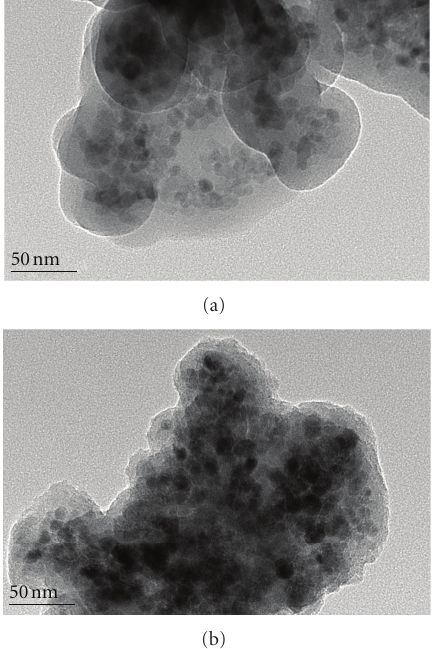
Figure 4: TEM images of Fe 3 O 4 /SiO 2 (a) and Fe 3 O 4 /SiO 2 /TiO 2 composite microspheres (b).